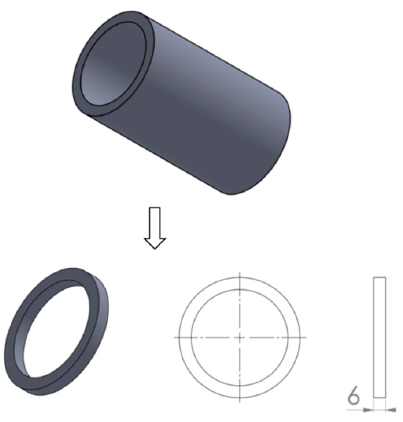
Figure 1. The schematic depiction of the specimen preparation.